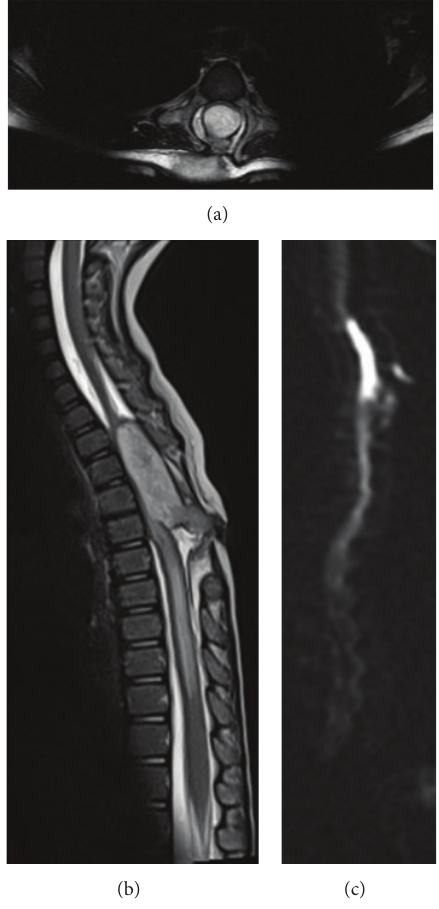
Figure 1:Axial T2-W(a),sagittal T2-W(b),andDW(c) MRimages. (a) A hyperintense well-defined, round, intramedullary lesion is seen spanning T3–T6 vertebral levels. (b) The hyperintense lesion demonstrates continuity with the skin surface consistent with a dorsal sinus tract. (c) There is hyperintensity of the spinal lesion on the sagittal DW image consistent with restricted water